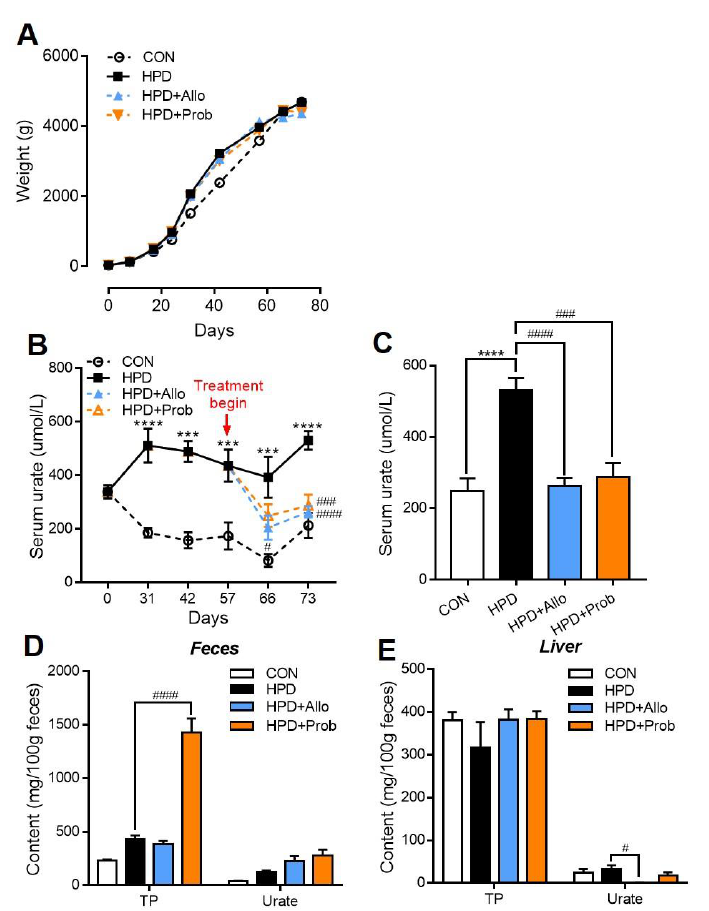
Figure 8. Allopurinol and probenecid treatment decreases serum urate in chickens of hyperuricemia. ( A ) Body weight. ( B ) Serum urate levels during consumption for 73 days, and allopurinol and probenecid treatment began at 57 days and remained until experiment finished. ( C ) Serum urate levels at the end of experiment. ( D ) Feces purine and urate content. ( E ) Liver purine and urate content. Values are presented as the mean ± SEM. n = 8–10, *** p < 0.001 and **** p < 0.0001 compared with CON; # p < 0.05 ### p < 0.001 and #### p < 0.0001 compared with HPD by one-way ANOVA.